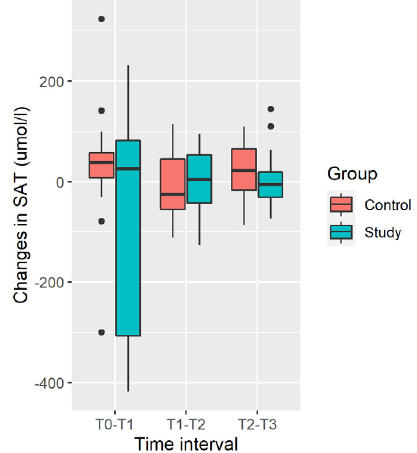
Figure 4. Distribution of changes in SAT.